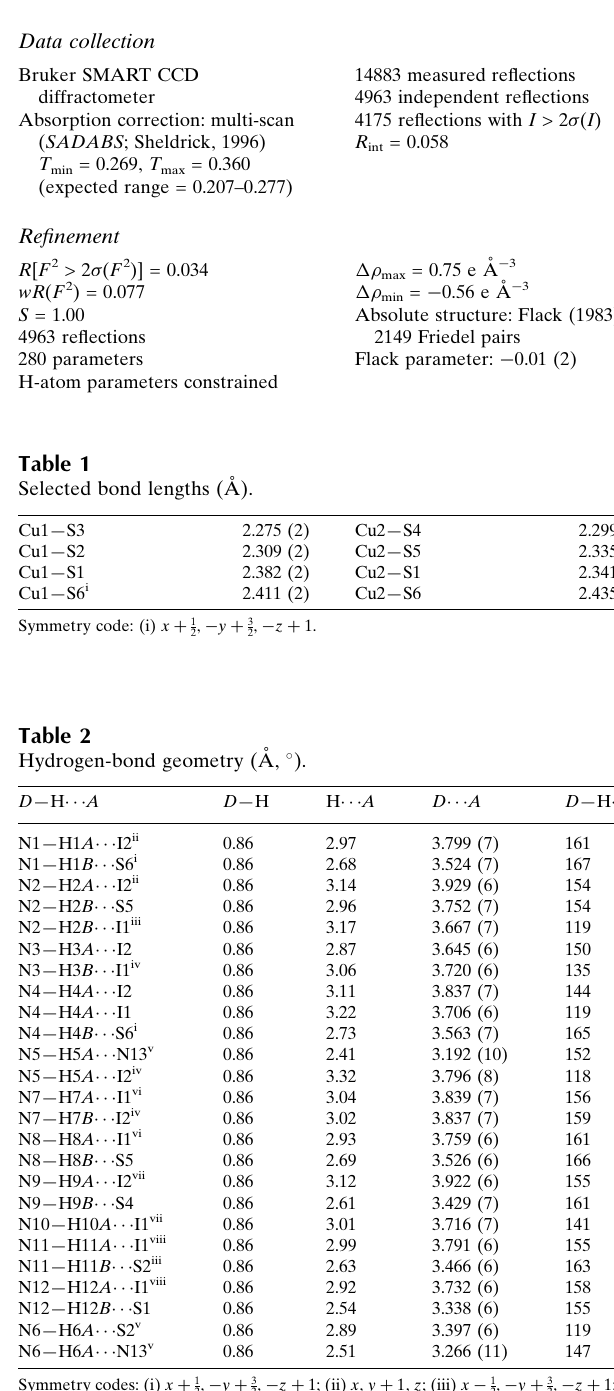
Experimental Crystal data